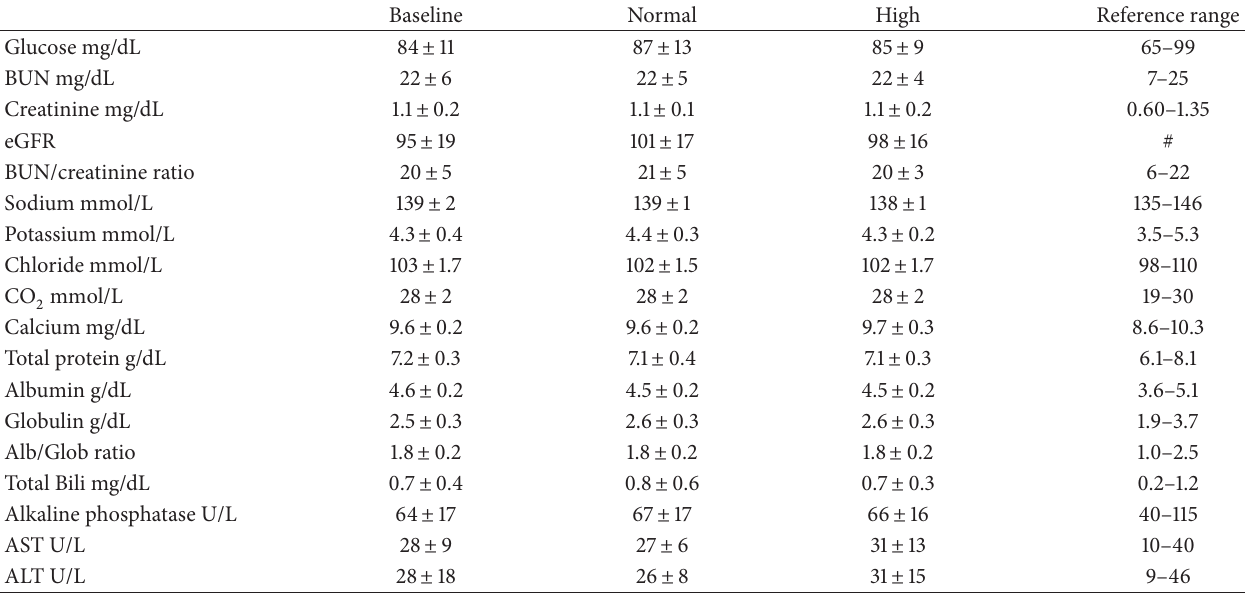
Table 4: Comprehensive metabolic